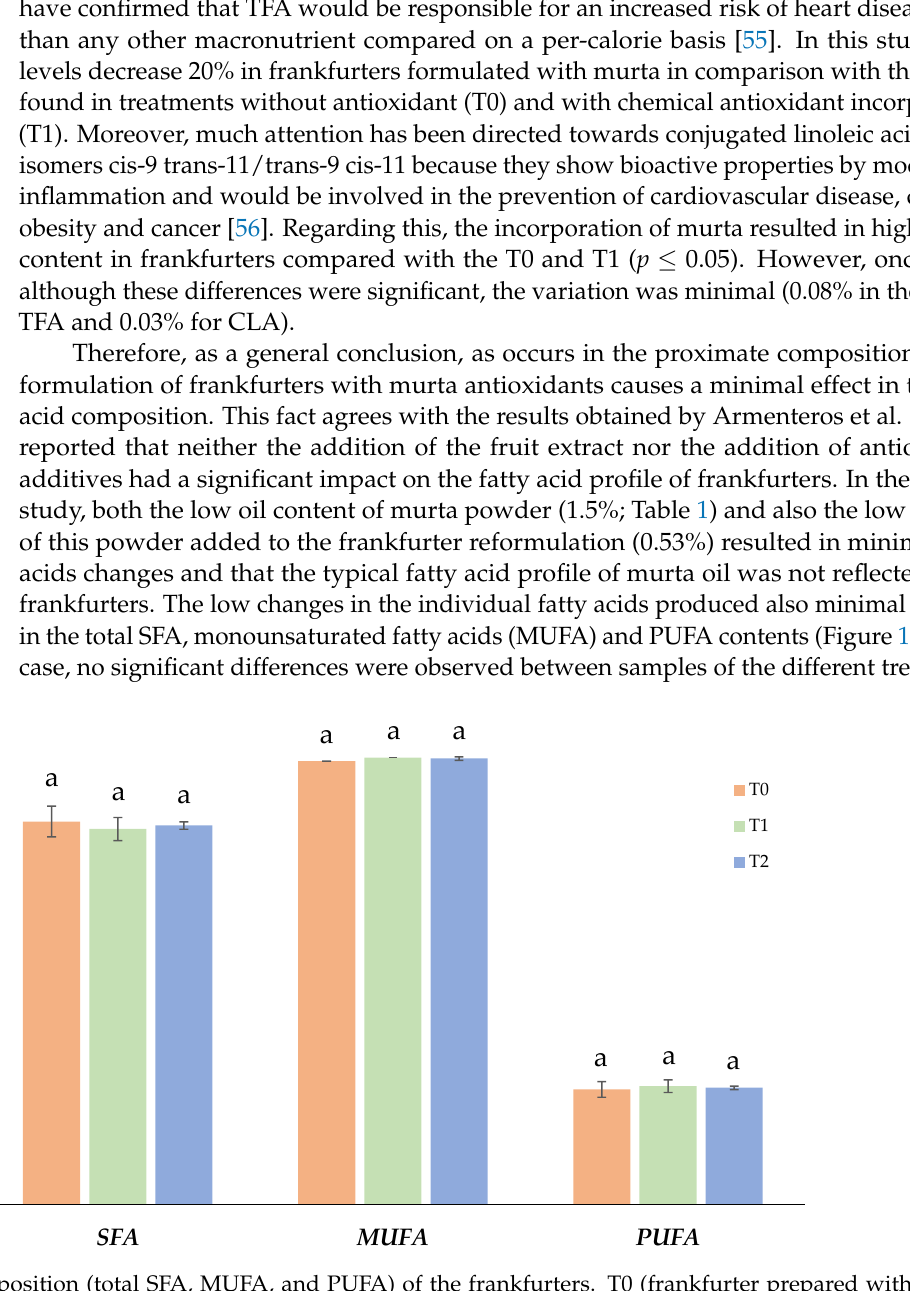
Figure 1. Fatty acid composition (total SFA, MUFA, and PUFA) of the frankfurters. T0 (frankfurter prepared without antioxidant), T1 (frankfurter prepared with Plus Color) and T2 (frankfurter prepared with murta as antioxidant). Different letters indicate a significant difference between treatments ( p ≤ 0.05; Tukey test). Error bars correspond to standard error.